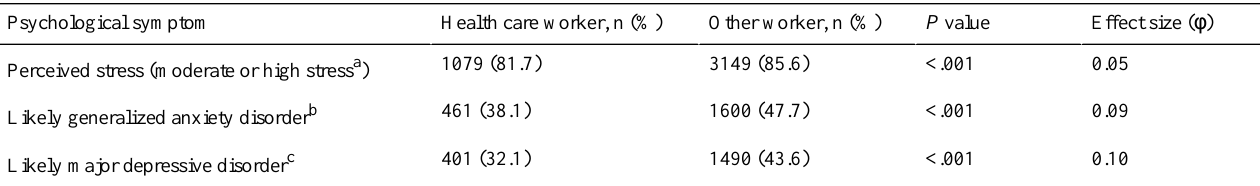
Table 2. Chi-square test of association between worker type, perceived stress, likely generalized anxiety disorder, and likely major depressive